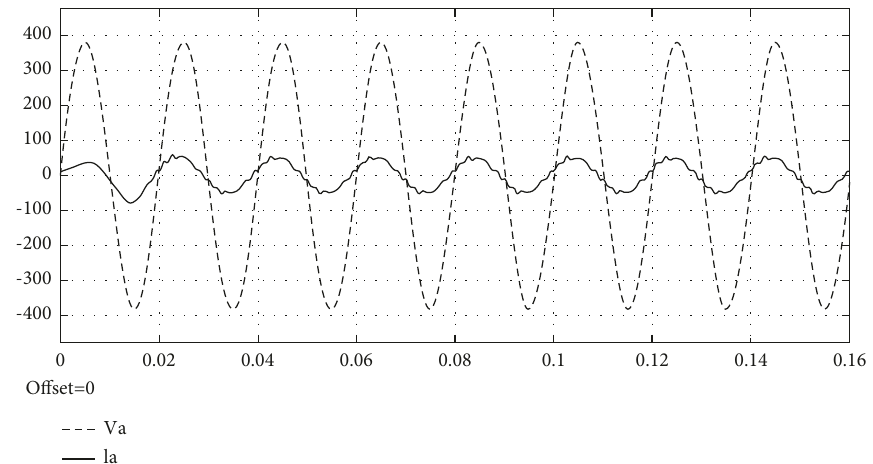
Figure 7: Input voltage and current waveform.